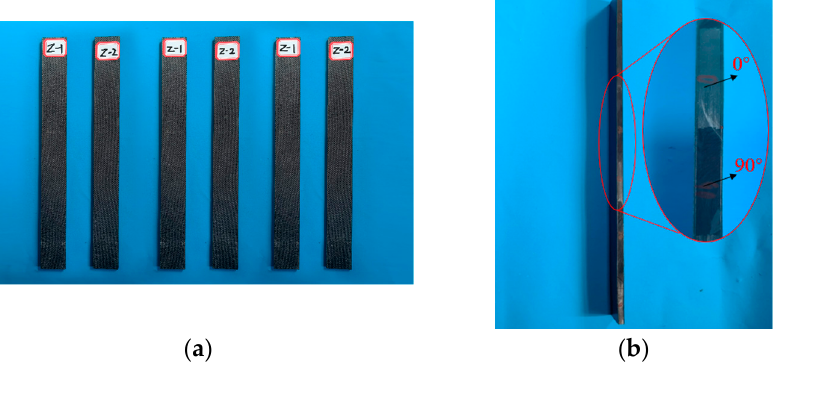
Figure 4. ( a ) Front view of specimens, ( b ) Side view of CFRP laminate with periodic structures, and ( c ) The specimen fabrication process.